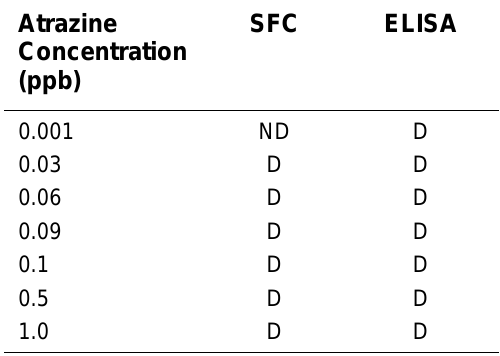
ND: not detected, D: detected.